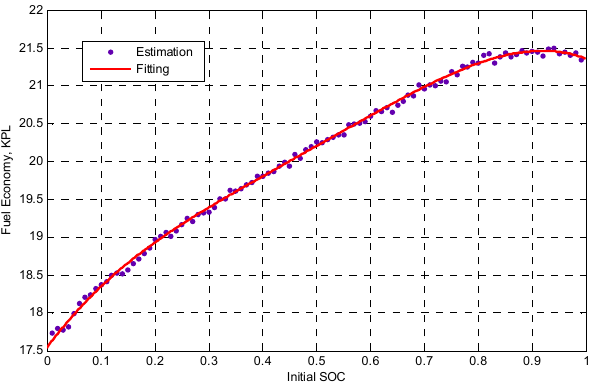
Figure 11. Relationship between Fuel Economy and Initial SOC.